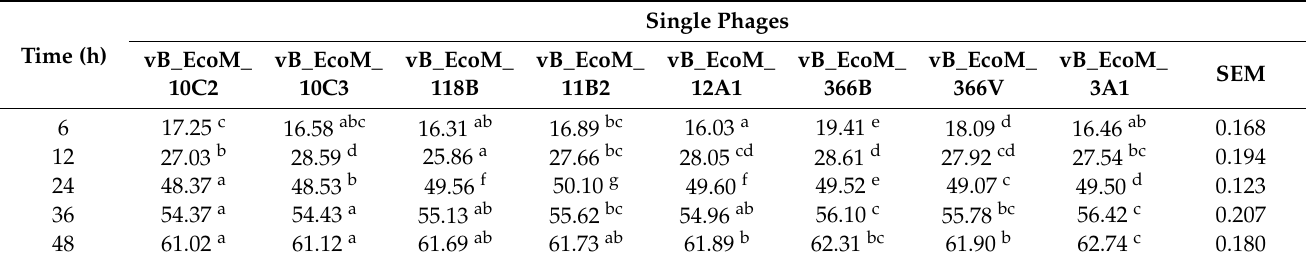
Table 3. Effect (% reduction) of single phages on E. coli O177 cells in a rumen fermentation model.